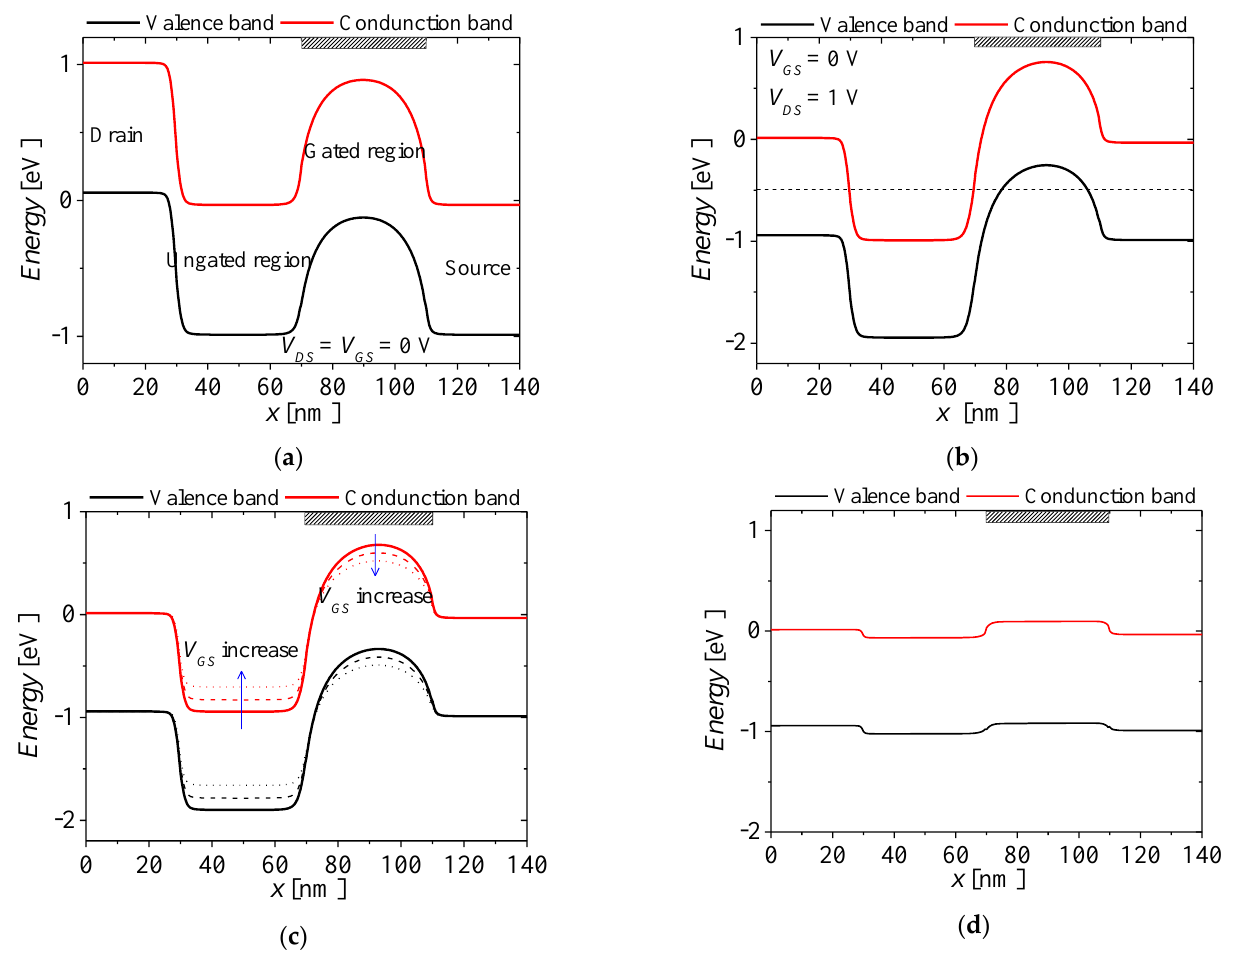
Figure 2. Energy band diagrams of NFBFET of each state. ( a ) initial state ( V DS = V GS = 0 V), ( b ) V GS = 0 V and V DS = 1 V, ( c ) forward sweep of gate − source voltage V GS at V DS = 1 V, ( d ) on − state by V GS at V DS = 1 V.